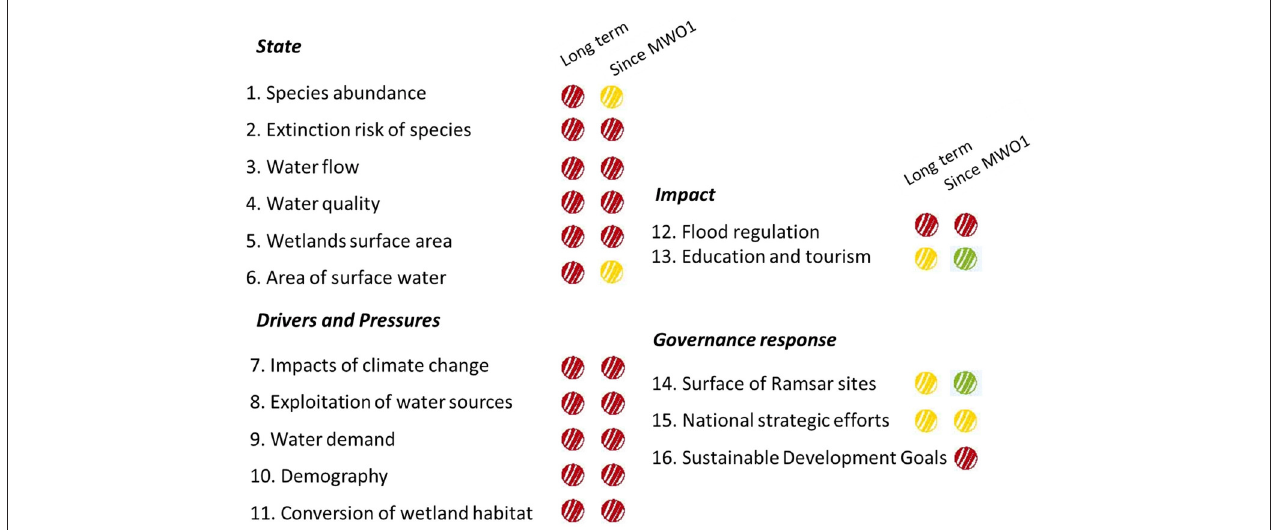
FIGURE 1 | Overview of the identified overall trend (long term starting from roughly 1970 depending on the data source until 2018) and the trend since the publication of the MWO1 (2012) for the 16 indicators of the MWO2 (2018). The color coding indicates if a trend is getting worse (red), is variable or stable (yellow), or is improving (green).